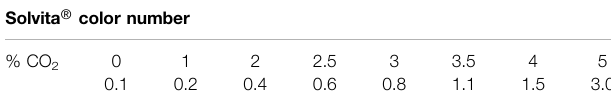
TABLE 8 | CO 2 concentration corresponding to Solvita ® color